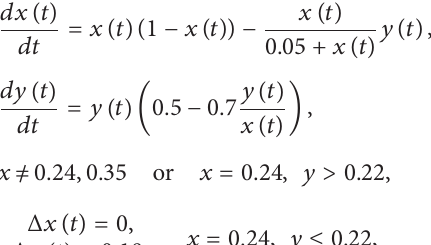
of system (6) is orbitally asymptotically stable. This